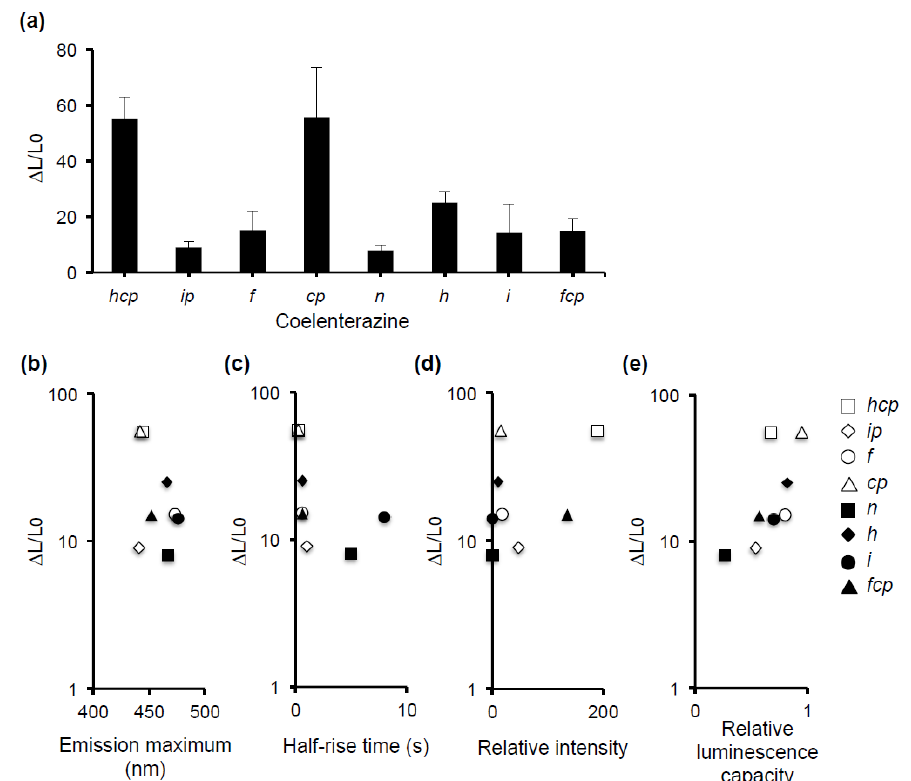
Figure 3. Comparison of the hTRPV1 activity of eight types of coelenterazines with different luminescence properties. ( a ) hTRPV1 activity induced by 10 µM capsaicin for each luminescent substrate. Data are presented as the average ( n = 3) ± SE (error bars) ( b – e ). Correlation between hTRPV1 activity and four luminescence characteristics of coelenterazines. Emission maximum, the maximum emission wavelength; half-rise time, time required for the luminescent signal to reach 50% of the maximum after the addition of 1 mM Ca 2+ ; relative intensity, the degree of Ca 2+ sensitivity relative to that of native aequorin (1.0); and relative luminescence capacity, total time-integrated emission of aequorin in saturating Ca 2+ relative to that of native aequorin (1.0) [39,40]. Each symbol represents different kinds of coelenterazine ( hcp , ip , f , cp , n , h , i , and fcp ). Opened square: hcp ; opened diamond: ip ; opened circle: f ; opened triangle: cp ; closed square: n ; closed diamond: h ; closed circle: i ; and closed triangle: fcp .